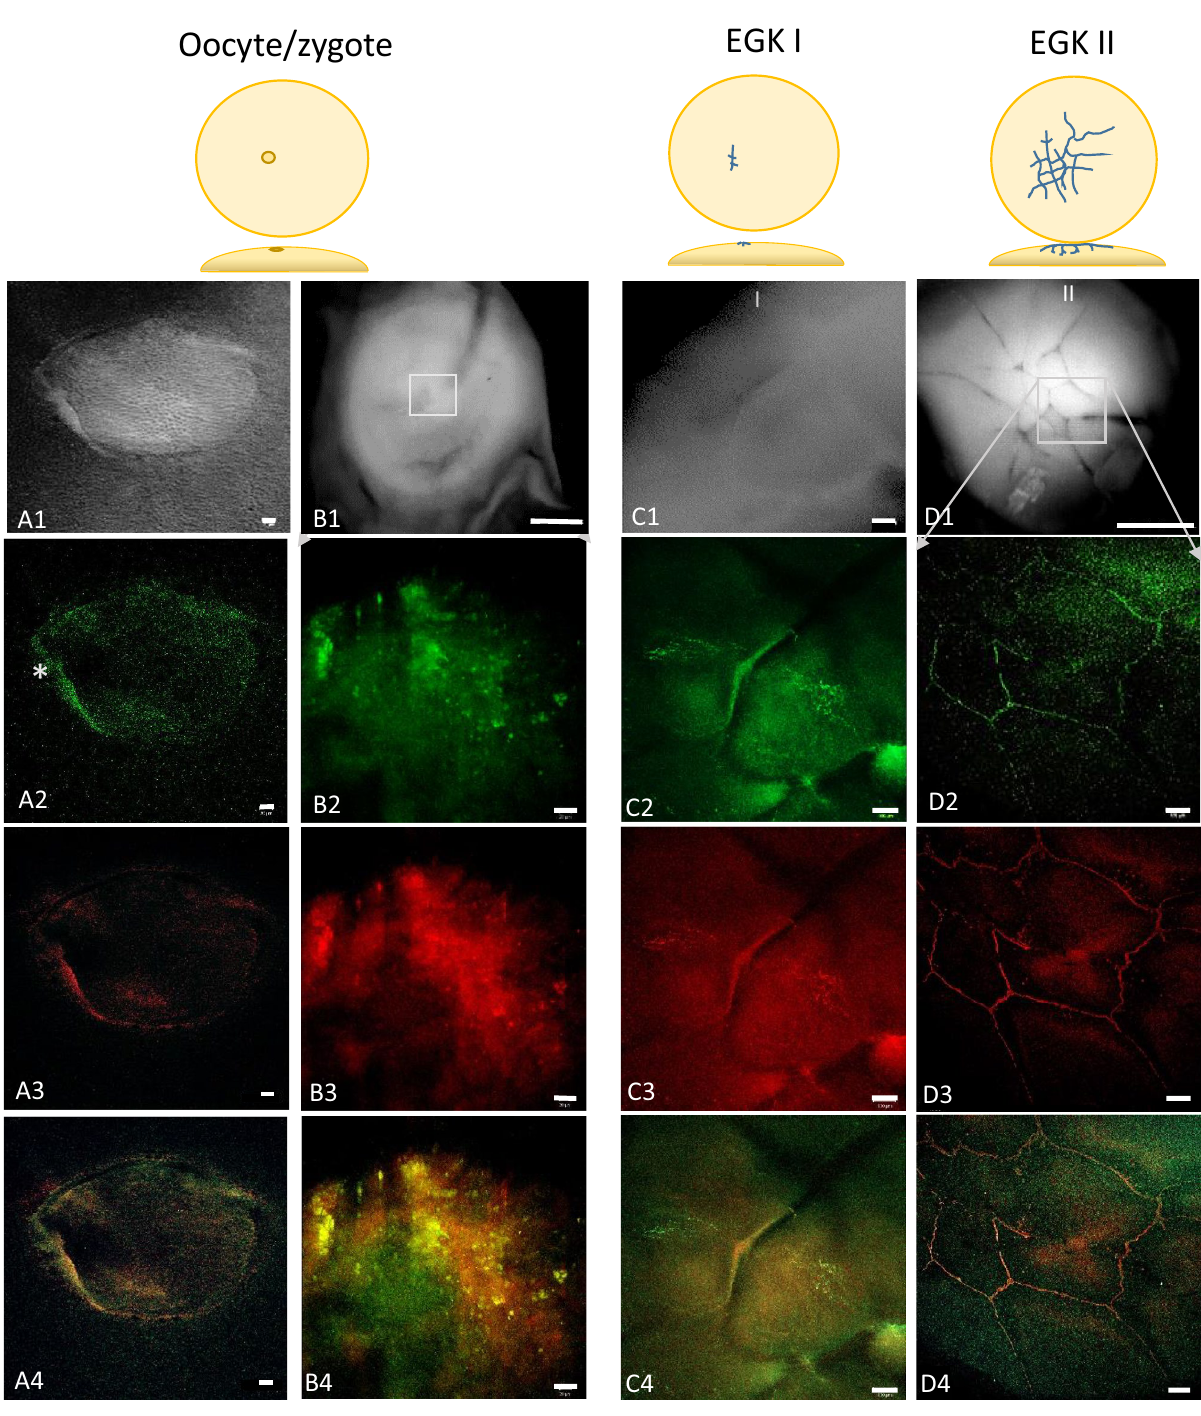
Figure 4. Accumulation of Bucky ball protein from the oocyte to early cleavage stages (EGK I/II) in chicken embryos. The upper panel represents differential interference ( A1 ) and bright field images ( B1,C1,D1 ) of the germinal vesicle ( A1 ), the total fragment containing the germinal disc ( B1 ) and the germinal disc regions ( C1,D1 ). Frames indicate the region of the higher magnified fluorescent images in the lower panels. Freshly ovulated oocytes are characterized by a diffuse distribution of the Bucky ball protein from a condensed outline of the germinal vesicle ( A2 ). At the outline, a higher Bucky ball concentration at one side (*) is apparent. After zygote formation, when the fertilized oocyte reached the isthmus part of the oviduct 2 to 2.5 h after fertilization, Bucky ball protein concentrates in granular patches in the center of the germinal disc where first cleavage furrows will be formed ( B2 ). The first cleavage furrow is lined by tightly aggregated Bucky ball, and in perpendicular orientation, the Bucky ball granules demarcate the predicted next furrow ( C2 ). During the next furrow divisions of stage I and II, further Bucky ball protein condenses in the cleavage furrows in the center of the forming embryo ( D2 ). There is no clear demarcation of cellular outlines yet. This pattern of protein distribution is highly colocalizing to CVH ( A3–C3 ), one of the first known germ plasm proteins as visualized in the overlay in A4–C4 ). Scales represent